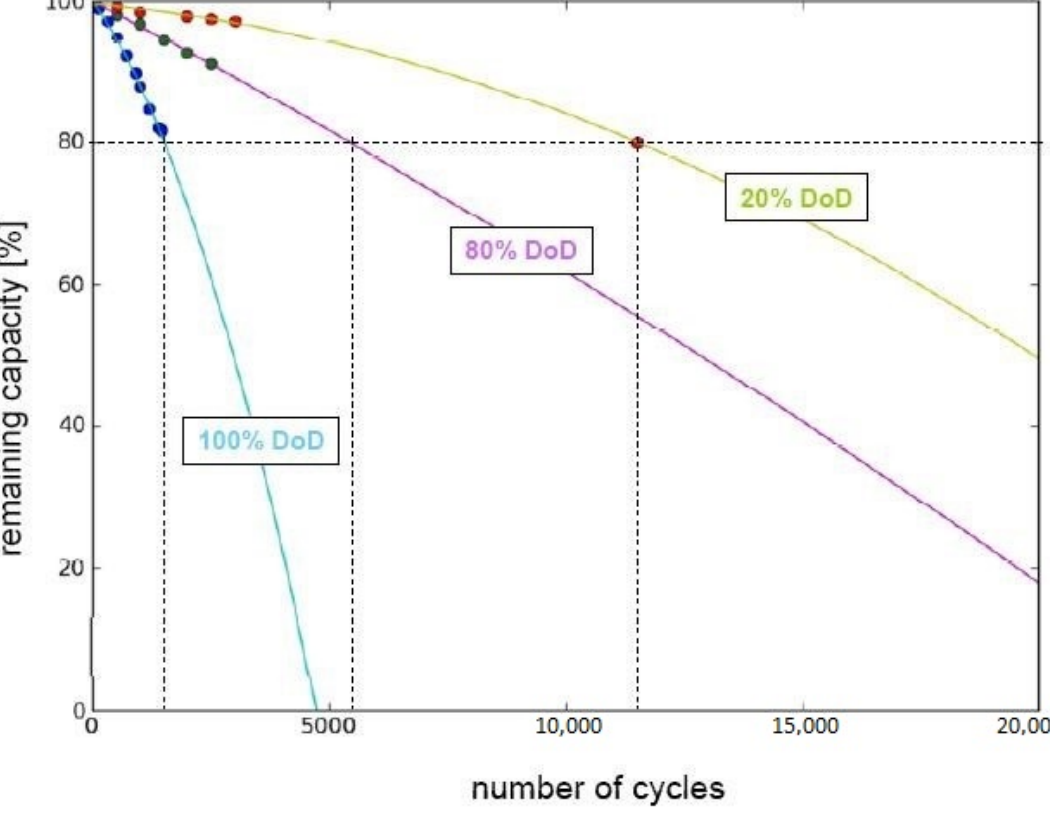
Figure 7. Li-ion battery usage curve: the energy storing capacity of the battery is found to drop with increasing number of charging/discharging cycles [55] .